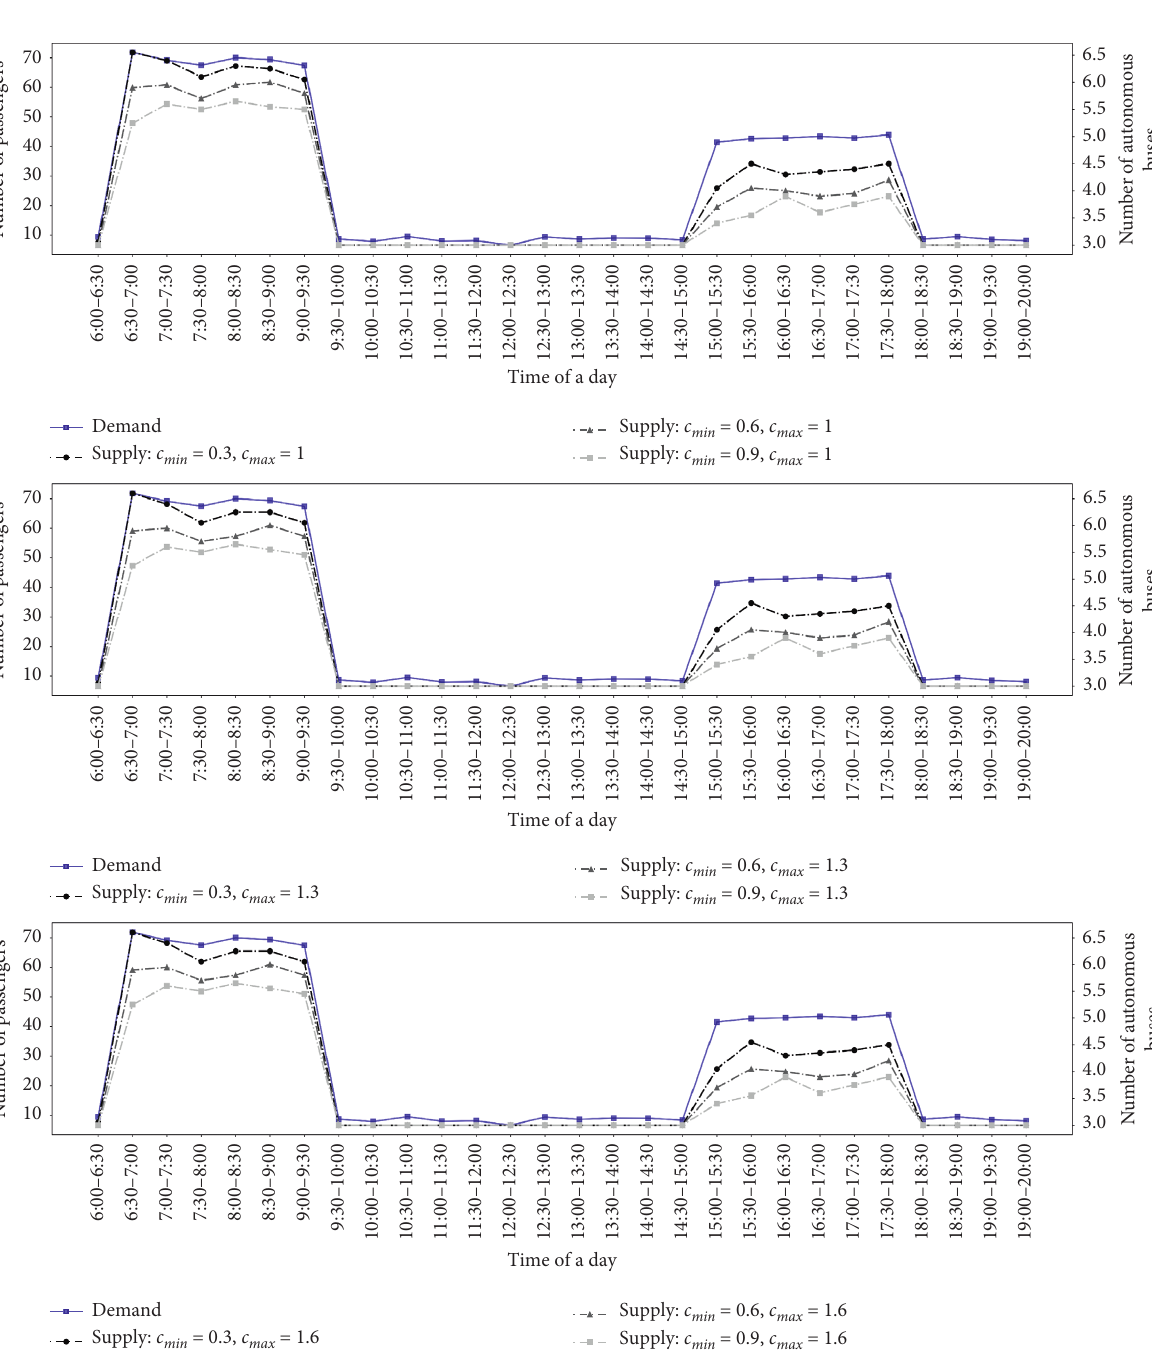
Figure 7: The variety of numbers of autonomous buses in a